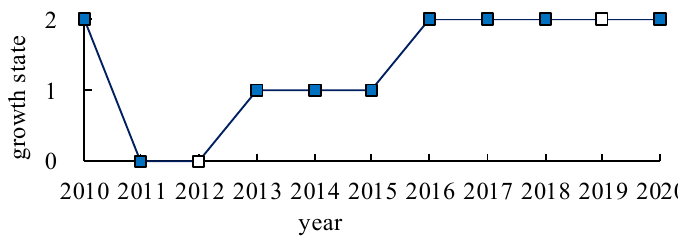
Figure 5. Growth process of the farmland shelterbelts shown in Figure 4.